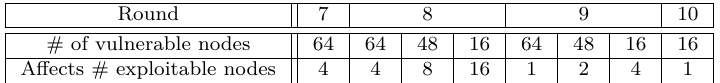
Table 7: Results of analysing AES-128 implementation using Algorithm